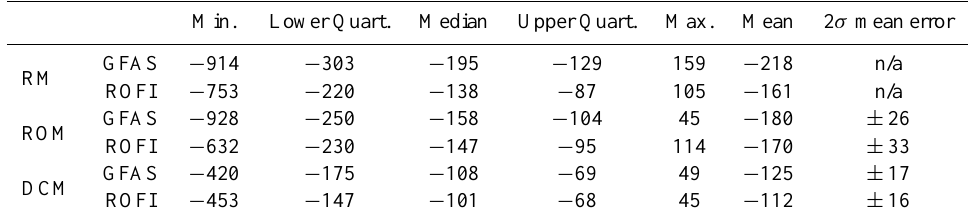
Table 1. Statistics based on whole GFAS and ROFI flux datasets for all calculation methods, using paired samples only. All values are in units of ngm − 2 s − 1 . Min. Lower Quart. Median Upper Quart. Max.